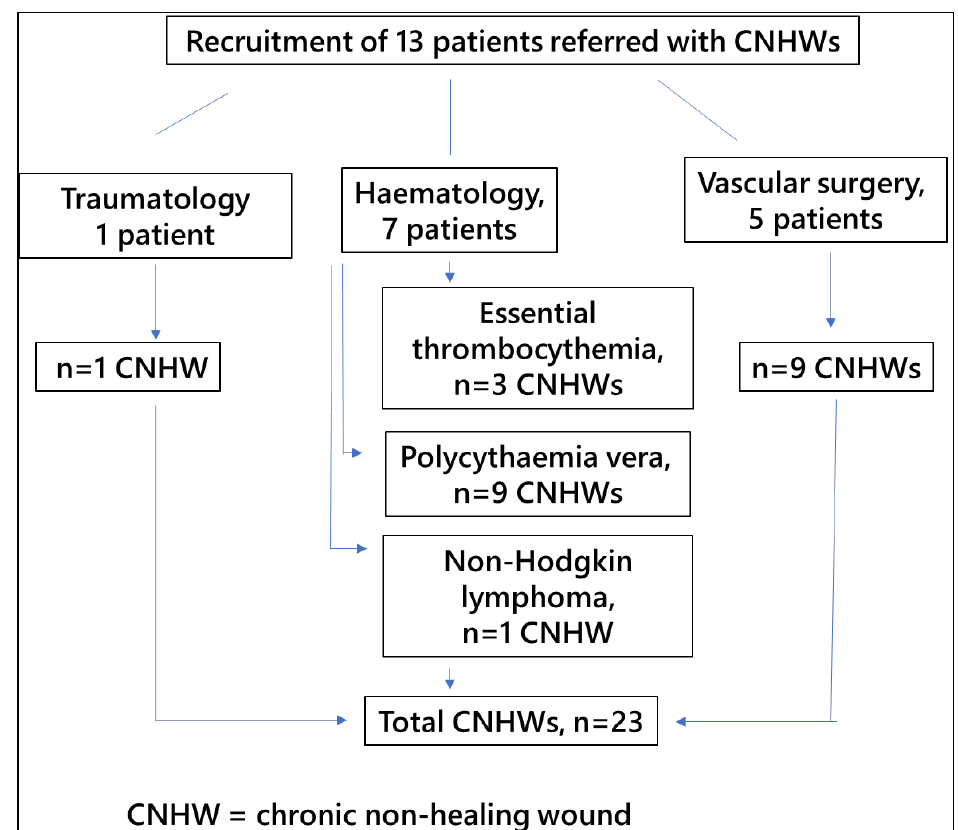
Figure 1. Flow chart of patients included in the study. Table 1. Descriptive analysis of the blood test results.